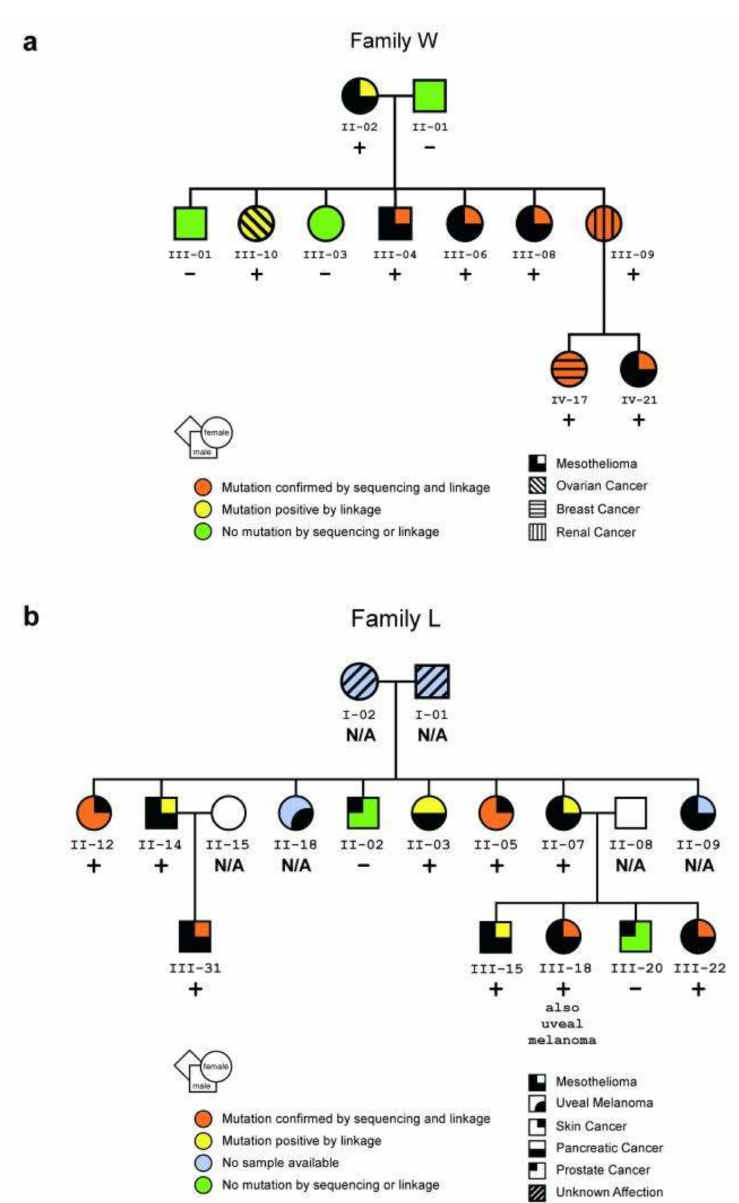
Figure 2. Pedigrees of two U.S. mesothelioma families. ( a , b ) Pedigrees showing family members with a germline mutation in BAP1 , as confirmed by both sequencing and linkage analyses (orange) or by linkage analysis alone (yellow, i.e., no DNA was available for sequencing); individuals without the mutation (green) and individuals for whom DNA was unavailable (blue) are also shown. Presence or absence of germline BAP1 mutation is also indicated with + or − symbols, respectively. ( a ) Pedigree of family W showing the presence or absence of a germline mutation at the BAP1 consensus splice acceptor site. ( b ) Pedigree of family L showing the presence or absence of a germline nonsense mutation. The development of other tumor types in these families may also be related to BAP1 germline mutations. In family W, the presence of a breast cancer before age 45 and an ovarian cancer suggests that the BAP1 mutation is associated with a hereditary form of breast / ovarian cancer, as might be expected given BAP1 (cid:48) s relationship with the breast / ovarian cancer susceptibility gene product, BRCA115. In family L, the skin cancers shown were squamous cell carcinomas. Reprinted with permission from Springer Nature Genetics (Germline BAP1 Mutations Predispose to Malignant Mesothelioma by Testa et al.) [18], Copyright ©